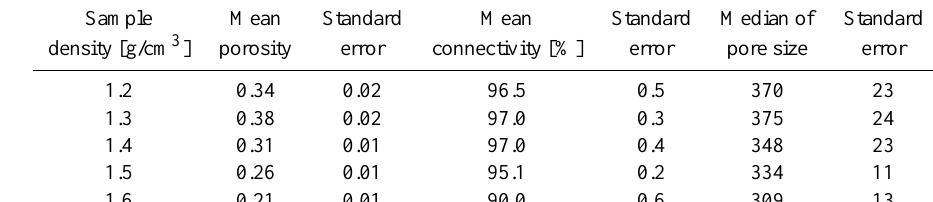
Table 1. Mean and standard error estimates of bulk physical characteristics for soil microcosms.